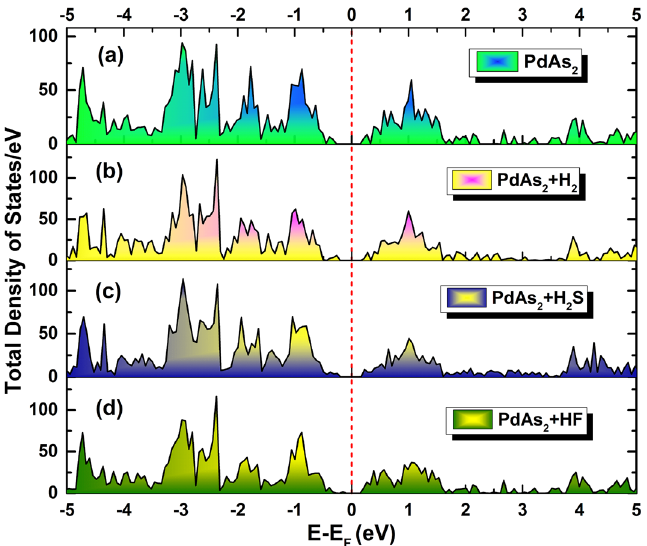
Figure 4. Total density of states/ eV of ( a ) penta-PdAs 2 with adsorbed ( b ) H 2 , ( c ) H 2 S and ( d ) HF gas